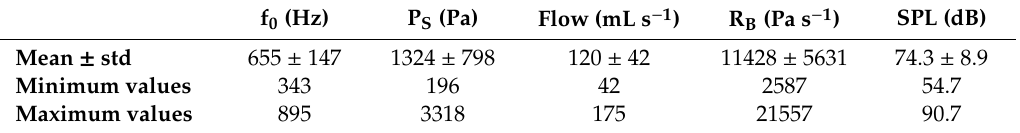
Table 2. Mean values, minimum and maximum values of the fundamental phonatory parameters.